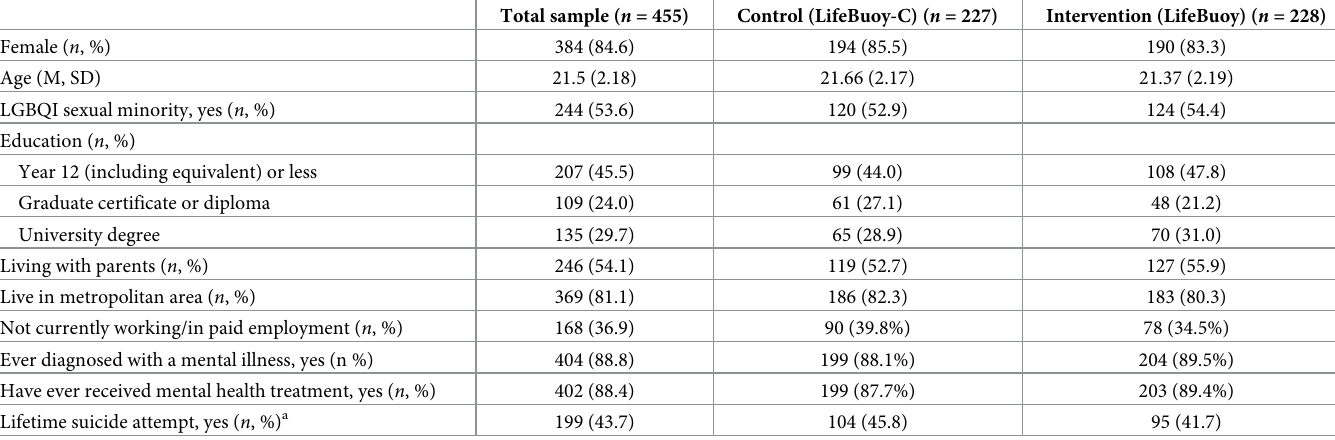
Table 1. Baseline characteristics of the total sample by